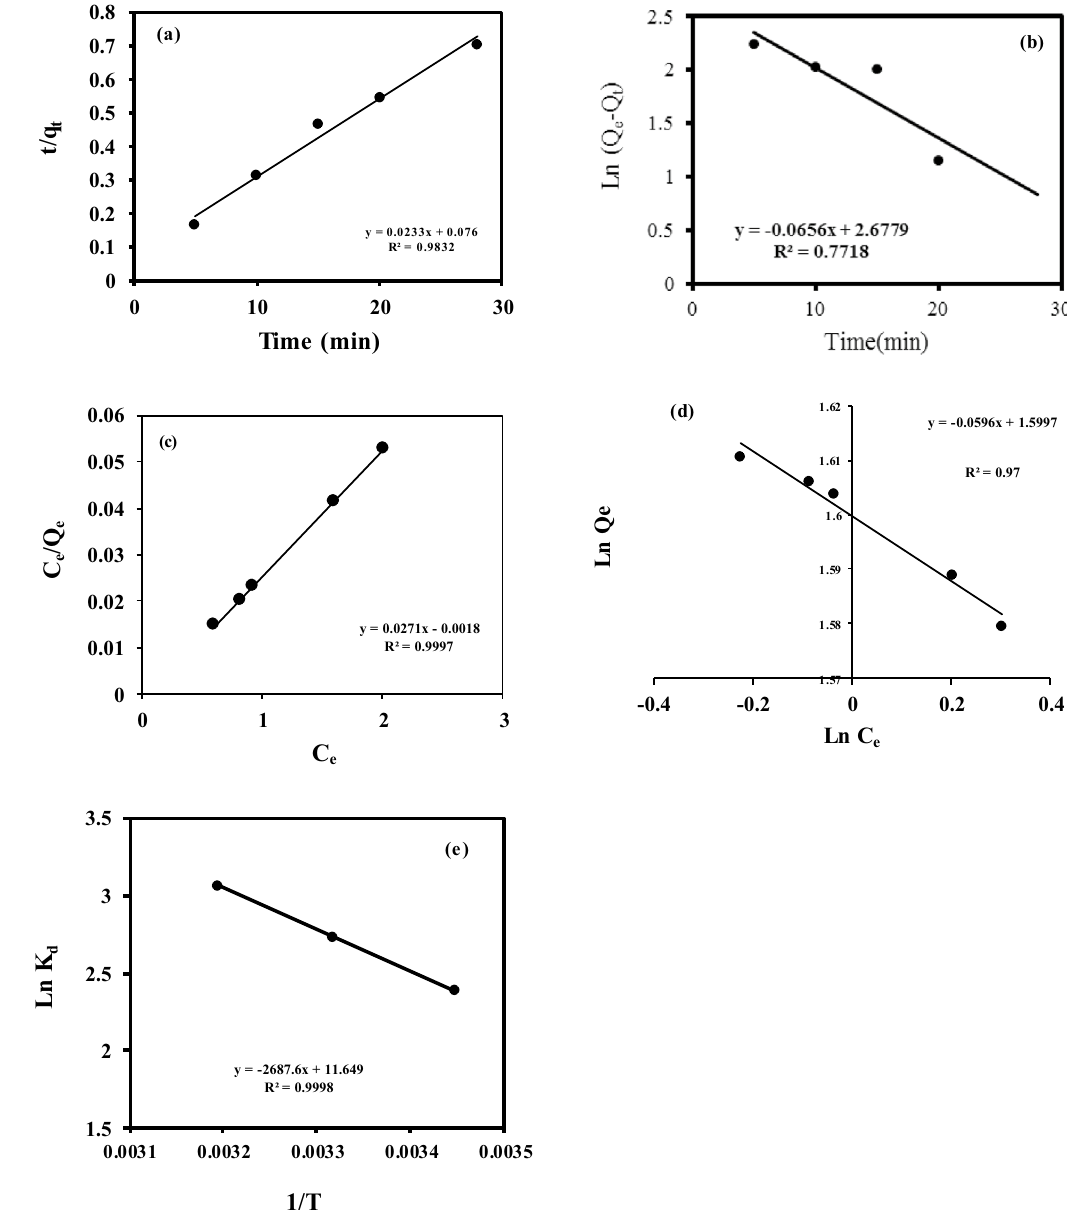
Figure 9. ( a ) Pseudo second-order; ( b ) Pseudo-first-order Lagergren adsorption curves; ( c ) Langmuir; ( d ) Freundlich adsorption isotherms; ( e ) Thermodynamics of adsorption of MB by the synthesized nanofibers